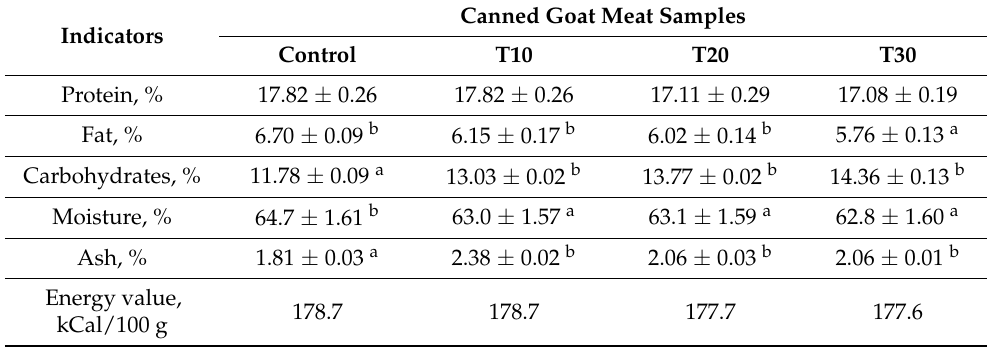
Table 2. Chemical composition of canned goat meat containing different amounts of carrot. Indicators